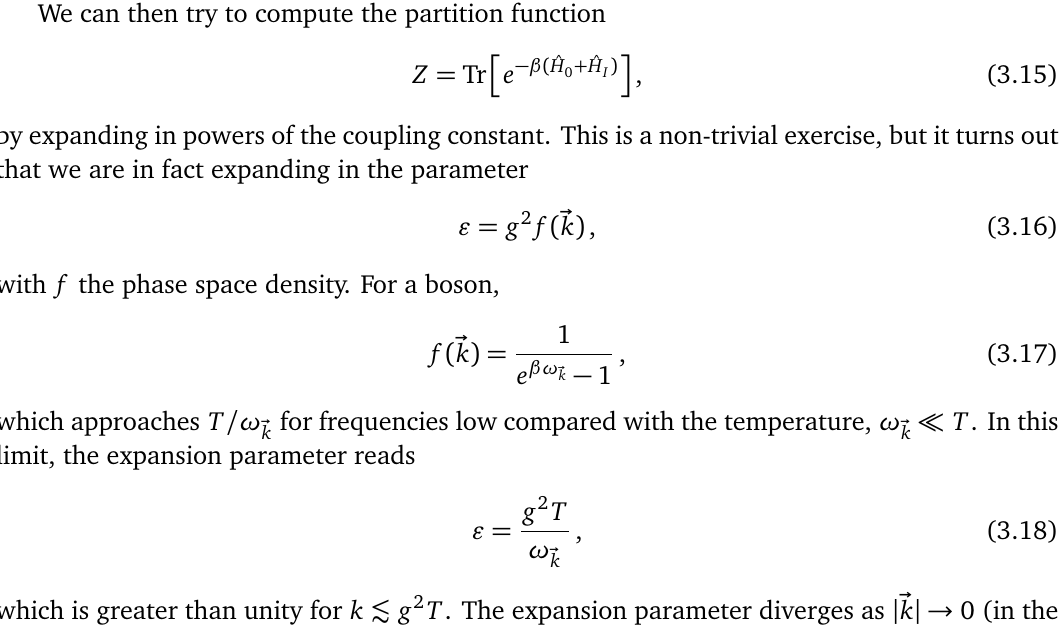
Figure 4: The figure shows the thermal effective Higgs potential V temperatures. For large temperatures T (cid:29) T at φ = 0 and the ground state is symmetric. Below the temperature T green) a second, but higher lying minimum develops. At the critical temperature T (green) both minima are degenerate. Below the critical temperature, the new c minimum at non-zero field value is the global minimum representing the true (stable) ground